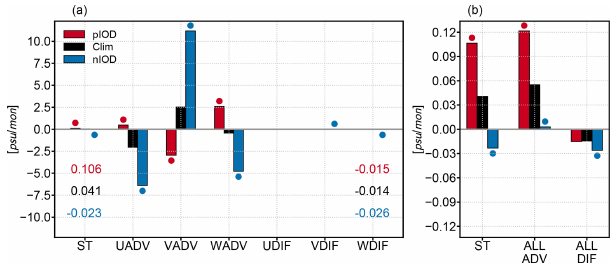
Figure 14. Domain-averaged subsurface (100m) salinity tendency and related salinity change rate terms of the BoB during ASO of pIOD years, nIOD years, and the climatological period, respec- tively, from HAMSOM (a) . The values of ST and WDIF in different cases are labeled with the corresponding color. The sum of all ad- vection terms and the sum of all diffusion terms are shown in (b) . Dots with corresponding color indicate that they are significantly different at the 95% confidence level using a two-tailed Welch’s t test compared to the